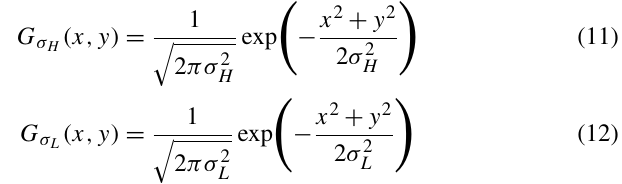
Figure 11. (a, c) Images of radiance L 0 . 87 and (b, d) of radiance ratios L 2 . 10 /L 0 . 87 for the spherical and optically thick water cloud ( τ c = 500) with a fixed r eff = 9µm and for a fixed scattering an- gle of ϑ s = 180 ◦ (a, b) and ϑ s = 150 ◦ (c, d) . The radiance ratio is shown to identify the origin of radiance pairs in the two-wavelength diagram (Fig. 12). As previously, the green and red dots mark view- ing configurations shown in Fig.